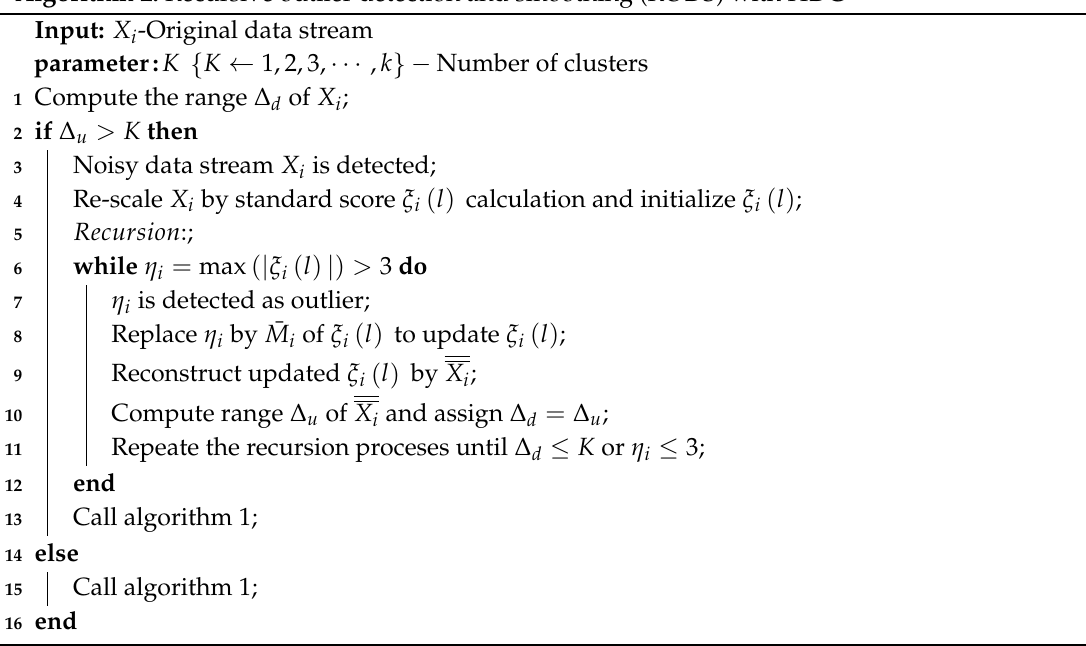
Algorithm 2: Recursive outlier detection and smoothing (RODS) with